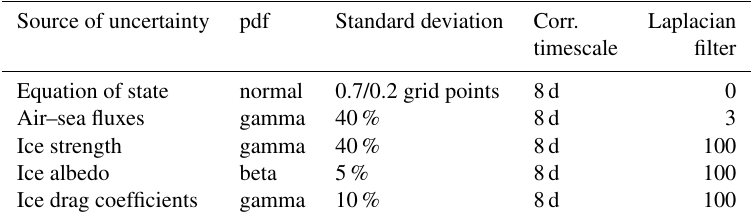
Table 1. Simulation of model uncertainties to perform the 70-member ensemble. It follows the working configuration used at Mercator Océan to perform ensembles for research and development in the context of CMEMS